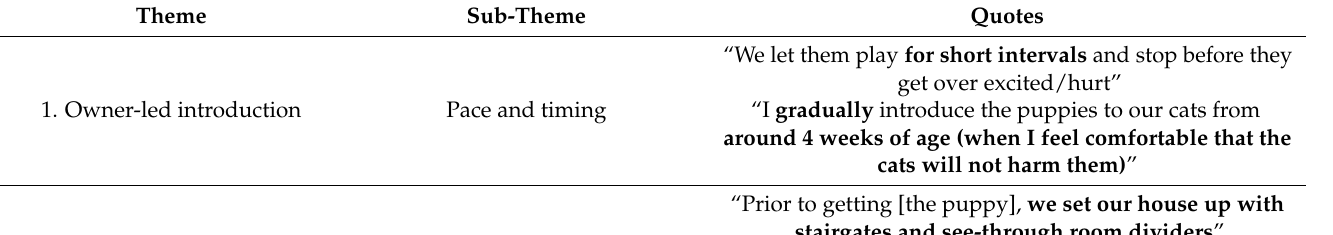
Table 6. Themes, sub-themes and quotes that illustrate cat-dog relationships and owners’ approaches to, and expectations of, introducing a puppy to a household cat(s). Text in bold highlights the crucial